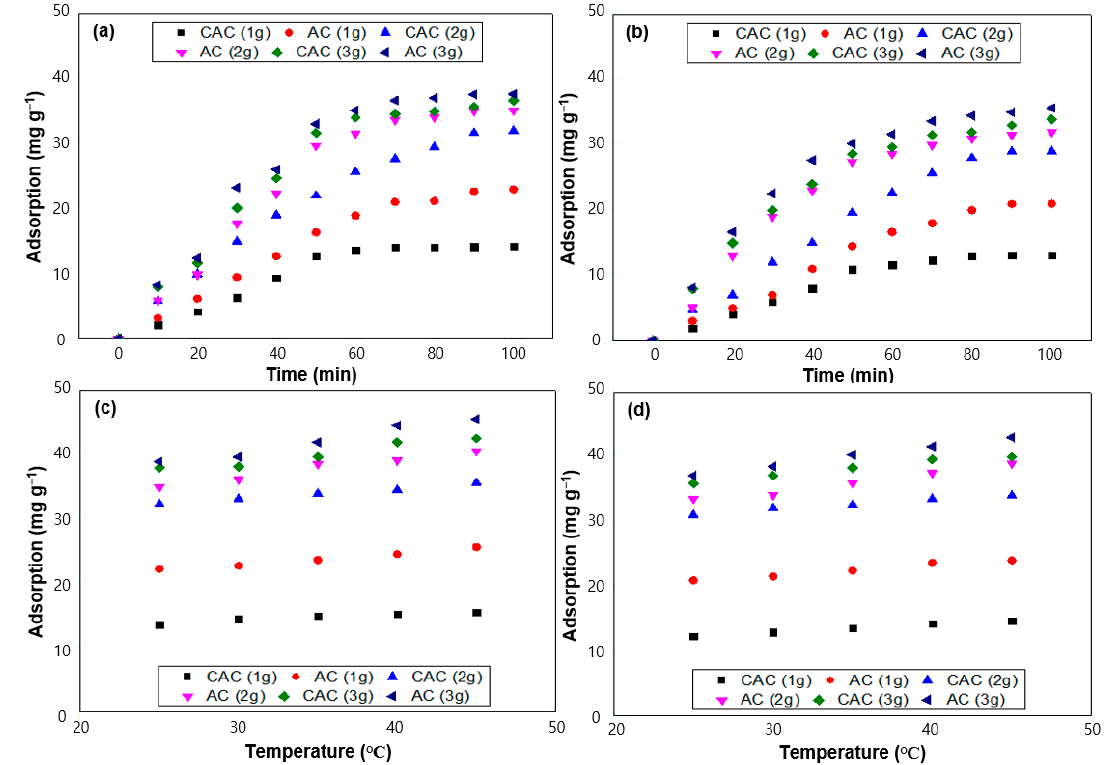
Figure 2. Adsorption performance of samples by various initial dosage is listed in ( a ) toluene and ( b ) benzene. The former with fi xed dosage (3 g) of samples by various temperatures is shown in ( c ) toluene and ( d ) benzene.